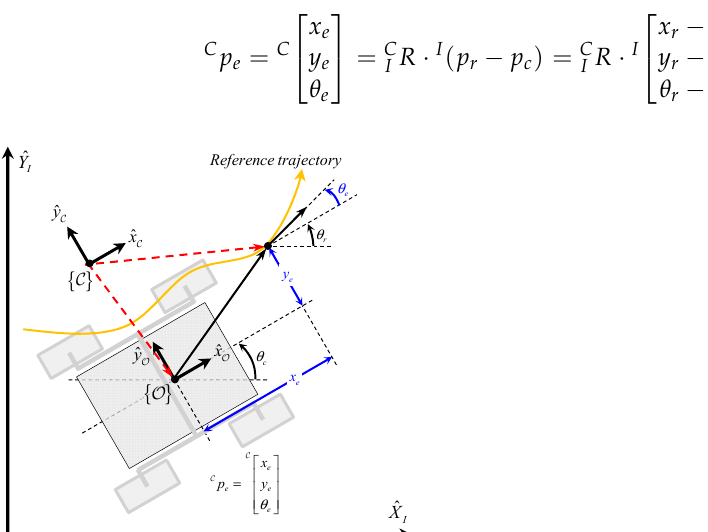
Figure 6. Posture error for the posture tracking controller.